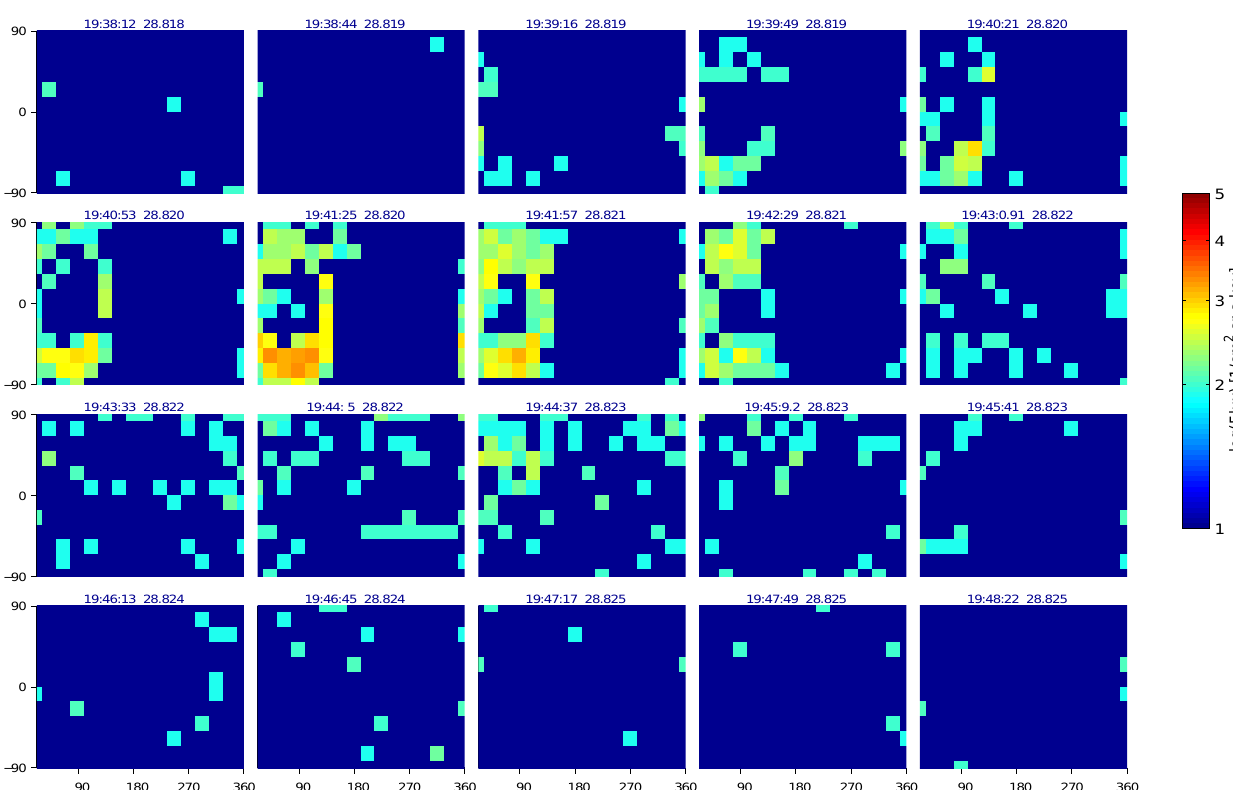
Fig. 6. Azimuthal and polar representations of energetic particle distributions measured by RAPID (30–60keV).